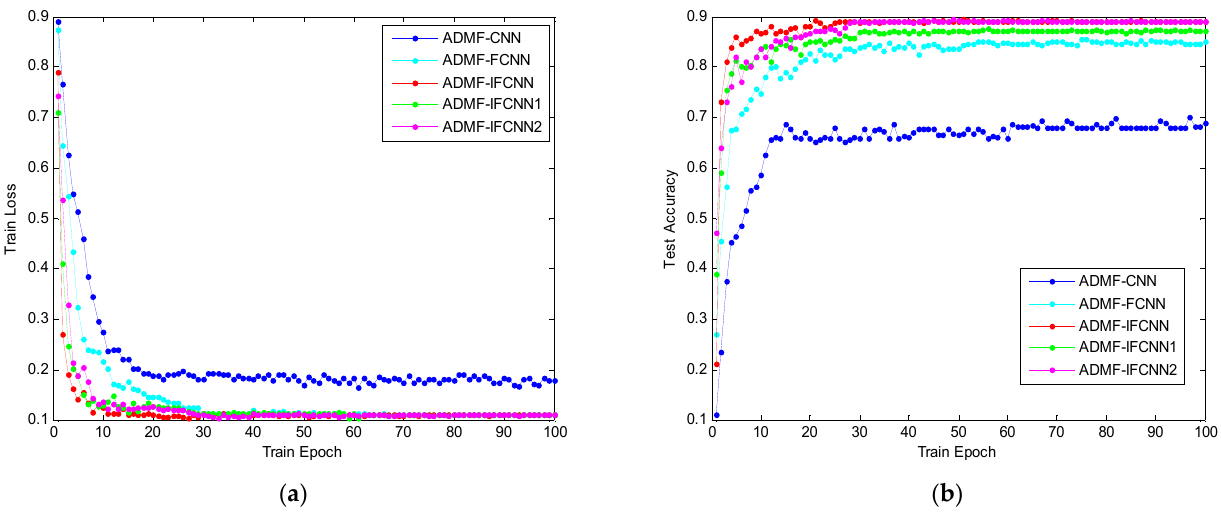
Figure 14. Convergence curves of five network comparison algorithms ( a ) training set loss; ( b ) test set accuracy.